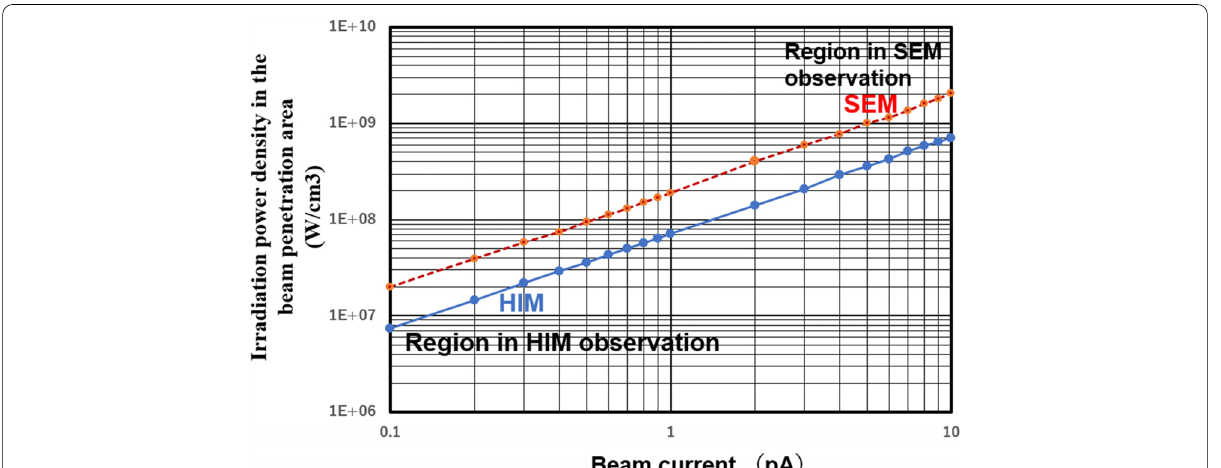
Fig. 3 The irradiation power densities for helium ions and electrons per unit volume as functions of the beam current for HIM (40 kV) and SEM (1 kV) observations of a sample. In the region associated with HIM observations (such as at 0.1 pA), the power density is more than two orders of magnitude lower than in the regions associated with SEM observations (such as at 10 pA). Figure modified from